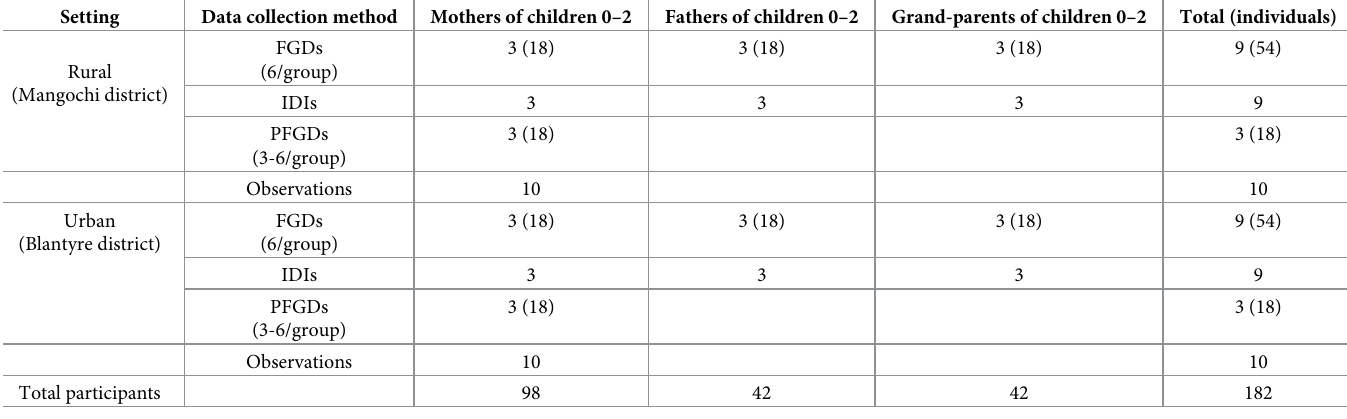
Table 1. Sampling matrix providing numbers of participants for all methods used in the study.